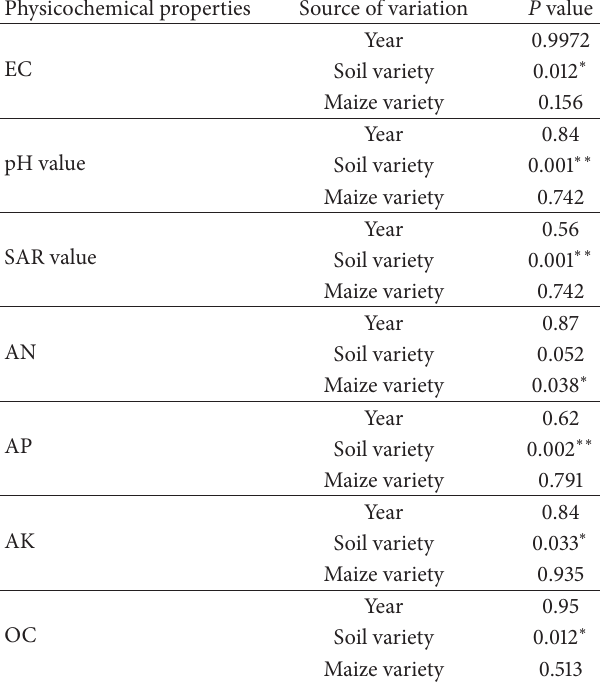
Table 5: ANOVA of seven physicochemical